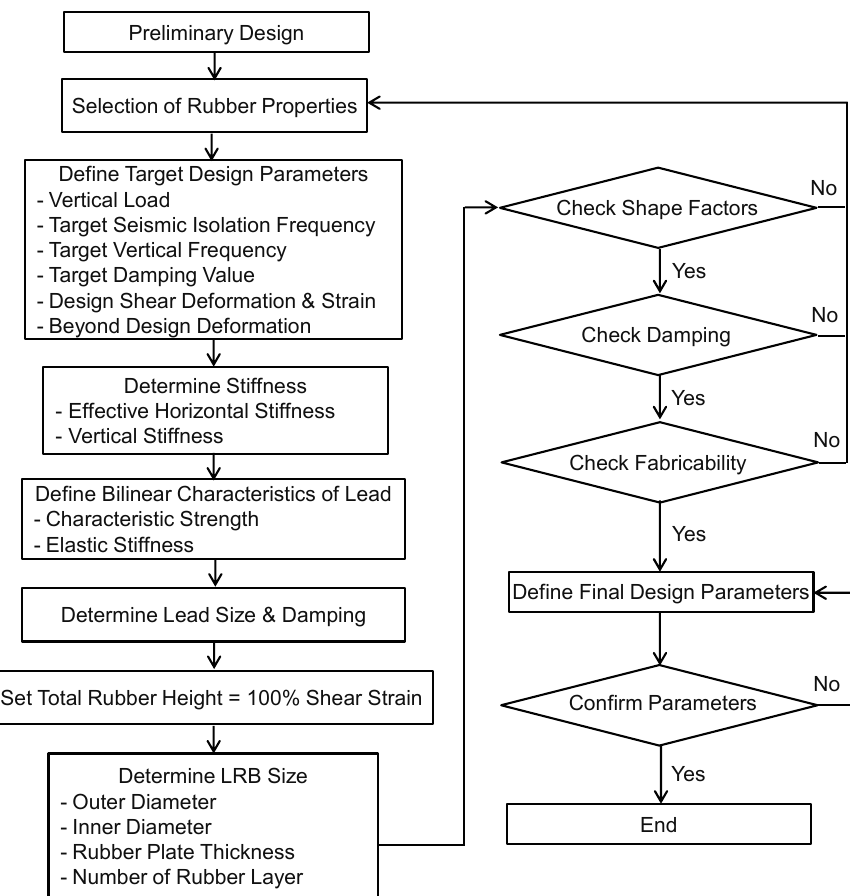
Figure 3. General procedures of LRB design.